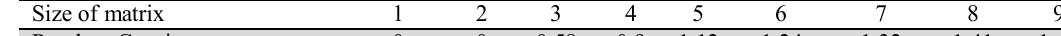
Average Random Consistency (RI) Size of matrix Random Consistency